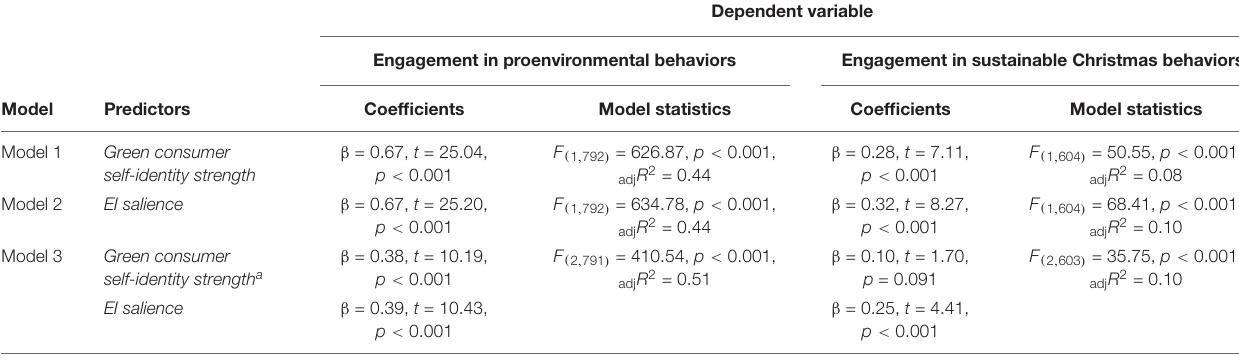
TABLE 8 | Linear regression models (Study